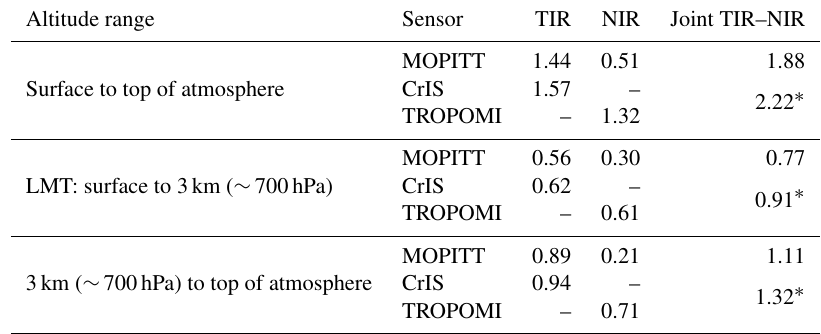
Table 4. Degrees of freedom for MOPITT, CrIS, and TROPOMI carbon monoxide measurements.